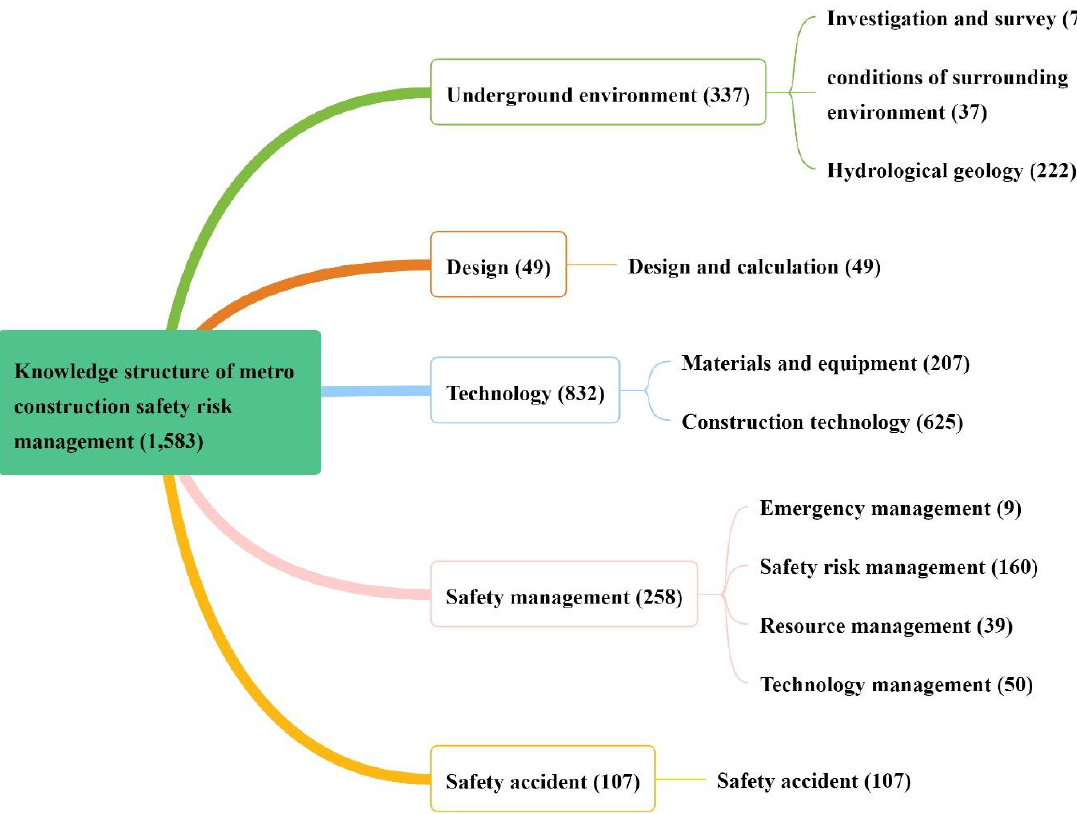
Figure 5. Knowledge structure of metro construction safety risk management.